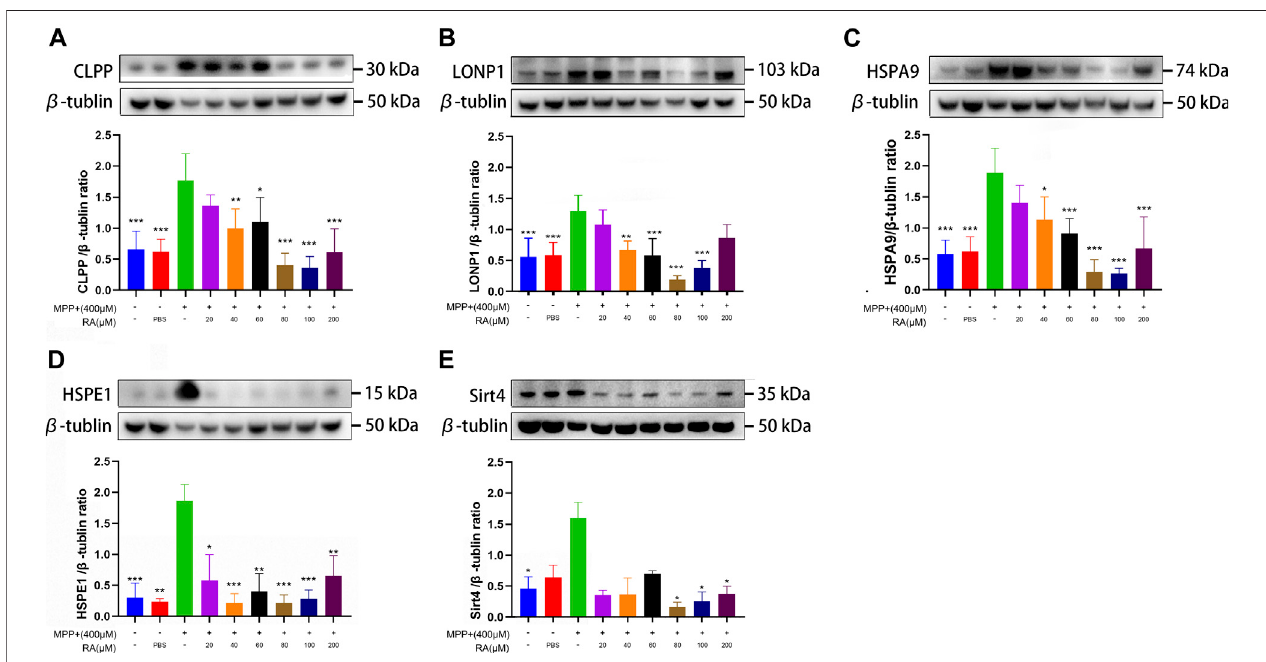
FIGURE 5 | RA alleviated MPP + -induced mitochondrial damage via the mtUPR in SH-SY5Y cells. MPP + caused a signi fi cant increase in CLPP (A) , LONP1 (B) , HSPA9 (C) , and HSPE1 (D) expression, and RA reversed these increases in a dose-dependent manner. RA regulated SIRT4 (E) expression in SHSY5Y cells. The expression of SIRT4 was increased by MPP + , and RA reversed this increase in a dose-dependent manner. Data are expressed as mean ± SD. One-way analysis of ANOVA with Tukey's test was used in CLPP, LONP1, and HSPA9. One-way analysis of ANOVA with Dunnett's T3 test was used in HSPE1 and Sirt4. N = 3-8 cell samples per group, * p < 0.05, ** p < 0.01, *** p < 0.001 when compared with the MPP +